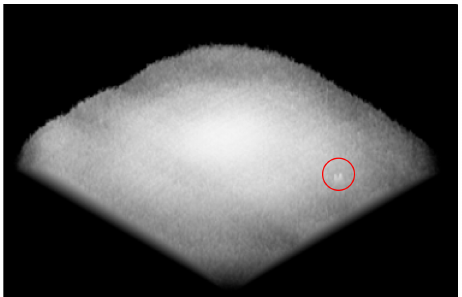
Figure 13. A 3D presentation (2D sensor pixel array—gray level) of the camera response to a weak defect on the tested surface. The height at each pixel represents for the gray value of the camera sensor